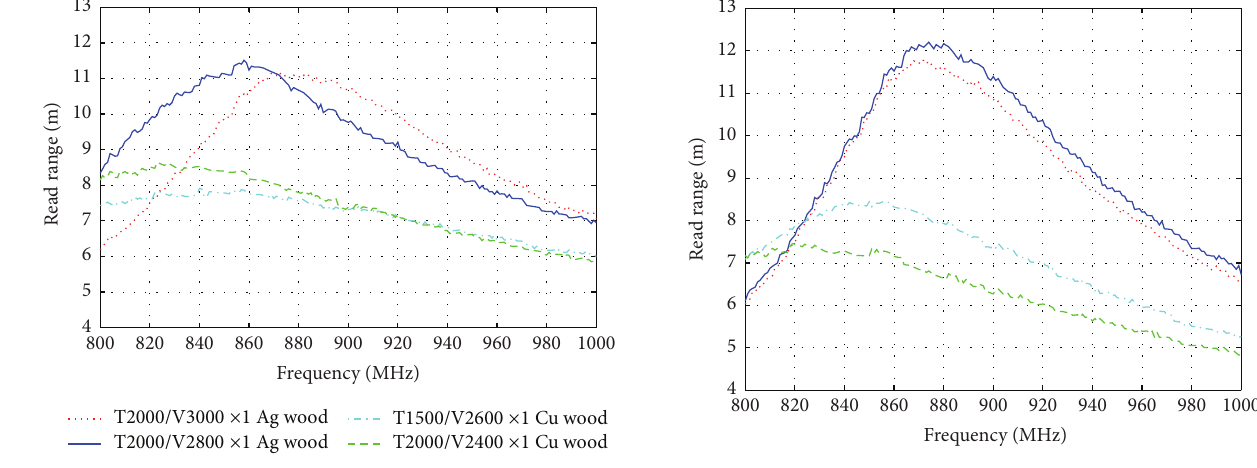
Figure 10: Attainable read ranges of copper and silver tags on wood substrates.